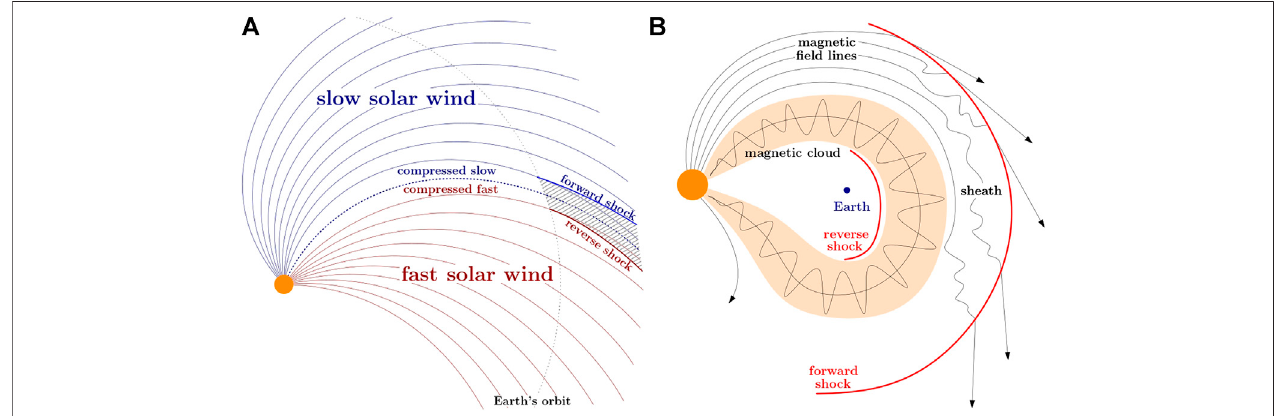
FIGURE 2 | (A) Schematics of the Co-rotating Interaction Region (CIR) which leads to a formation of CIR bounded by forward and reverse shocks; (B) A fast forward shock formation in front of an ICME and a possible reverse shock at the trailing edge of the magnetic cloud.